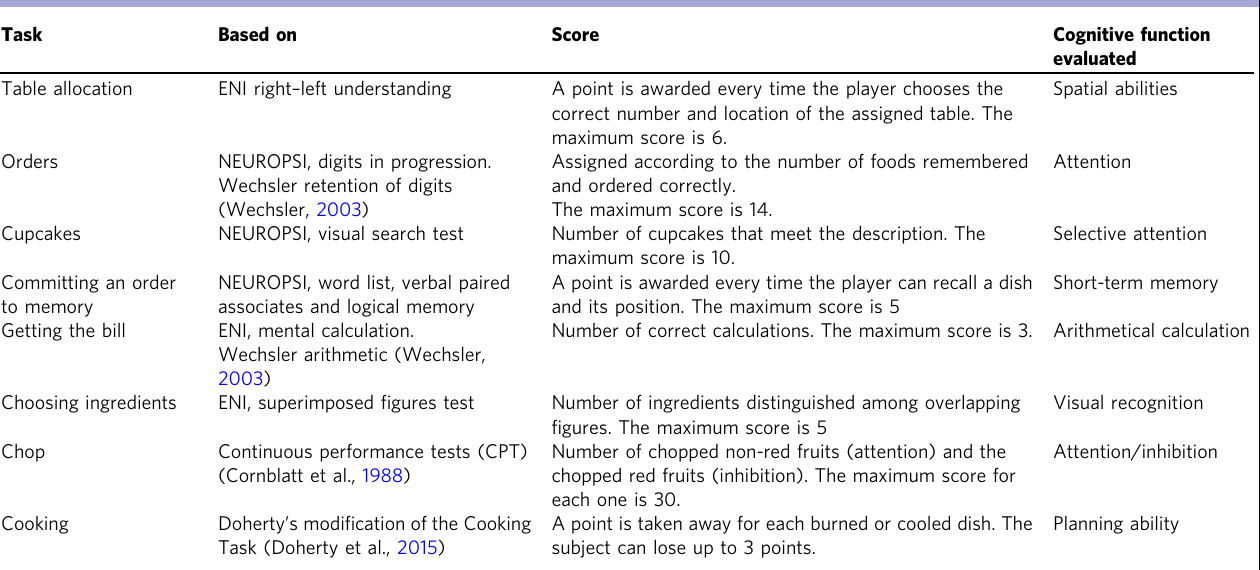
evaluated Spatial abilities